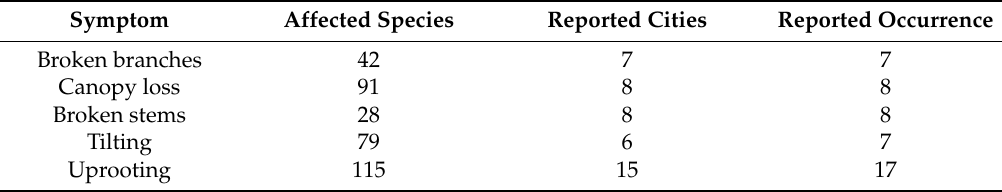
Figure 2. Spatial patterns of wind damages on urban trees in China. Table 3. Summary of wind impacts on urban tree species in China.